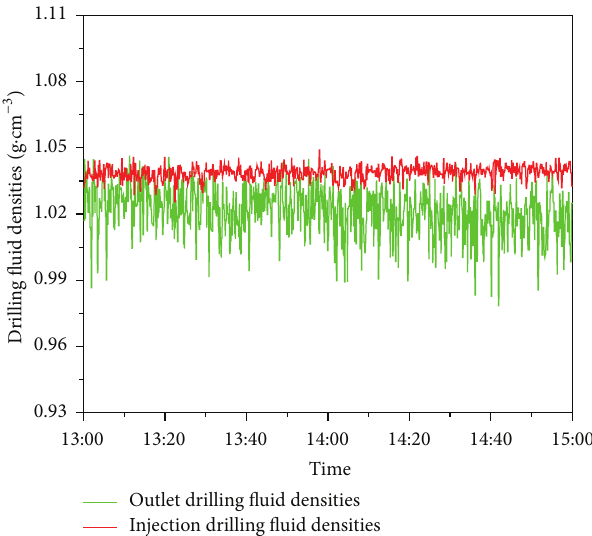
Figure 8: Data acquisition—drilling fluid density data versus time (2010-9-25).